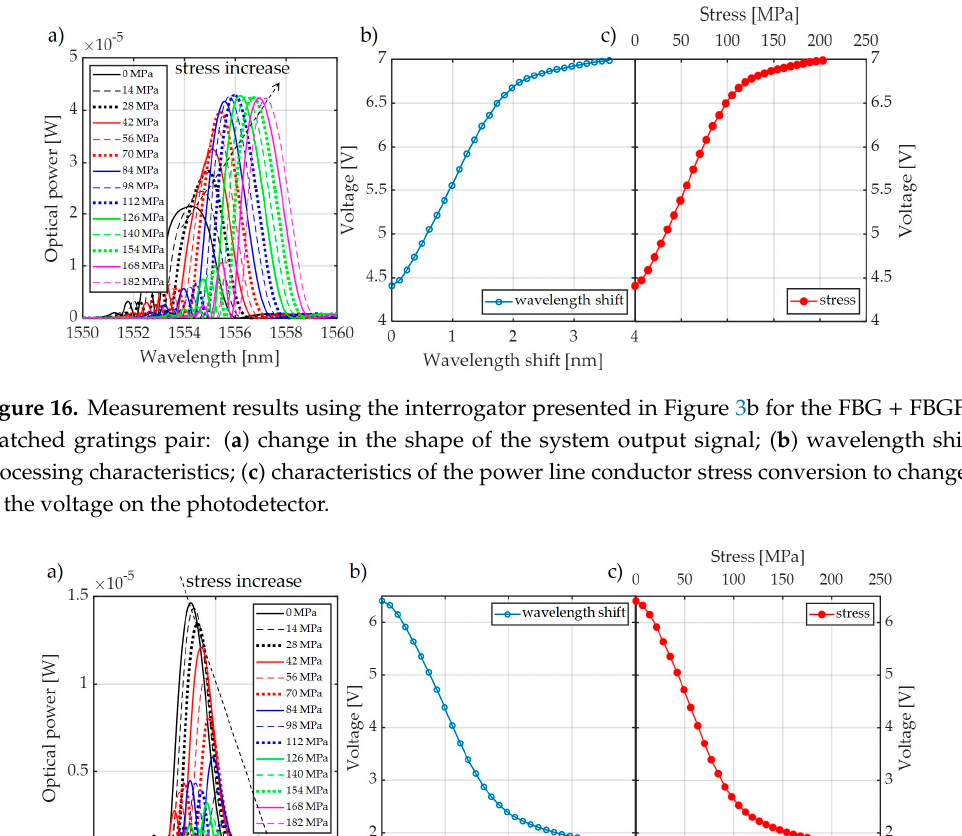
Figure 18. Outline of the outdoor testbed used for the proposed wire sag and temperature monitoring. 1: load cell Instron PM-L 2526-802 10 kN; 2: draw-wire displacement sensor Micro-Epsilon WDS 96/2500 mm; 3: ACSR Hawk wire with glued temperature sensor. The developed outdoor test stand is presented in Figure 19 and its key elements are indicated. Figure 19. The outdoor test stand and its key elements. 1: Load cell; 2: proposed photonic sensor system; 3: temperature measurement; 4: sag measurement; 5: moving pole; 6: weather station; 7: ACSR Hawk conductor; 8: high-current transformer. 5. Discussion Section 4 presents the results of measurements made on an outside test stand with an installed ACSR Hawk wire during tests loaded with an electrical current. The results of the photodetector